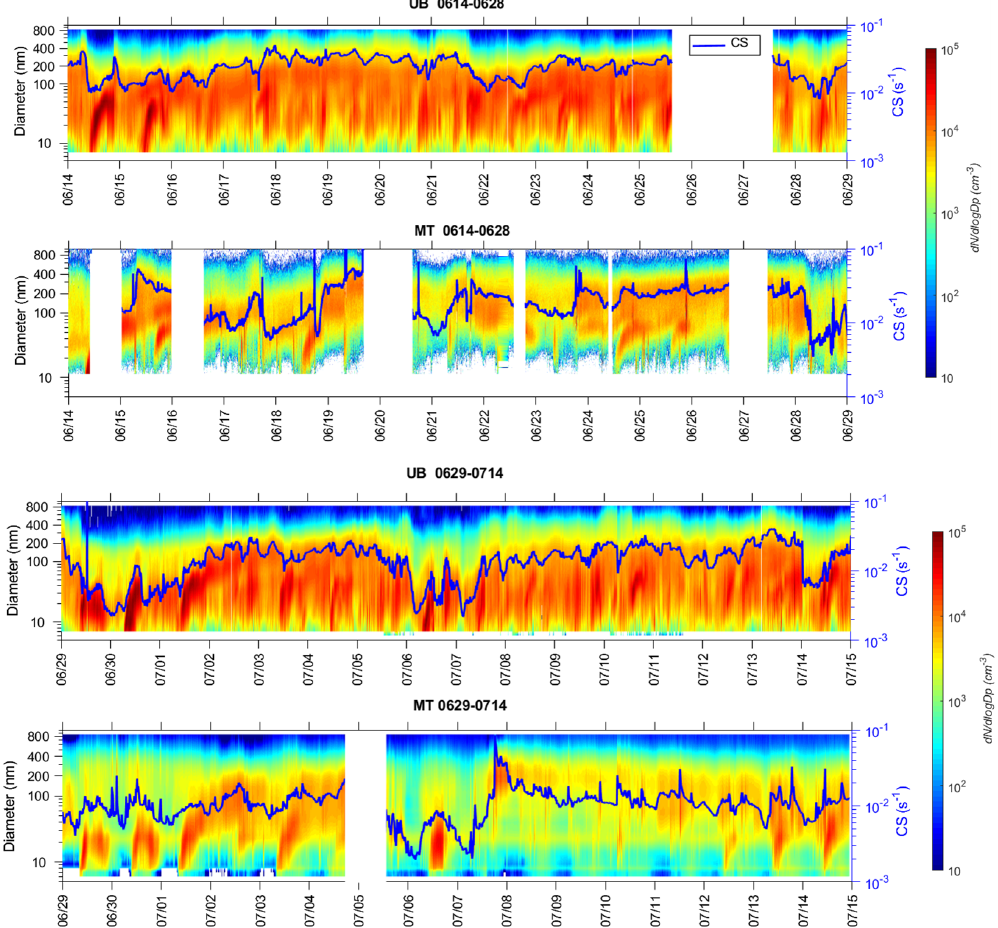
Figure 2. Time series of particle number size distribution and CS (blue line) at UB and MT stations during our observations. Time resolutions of particle number size distribution data and CS were 8min at the UB station and 4min at the MT station,